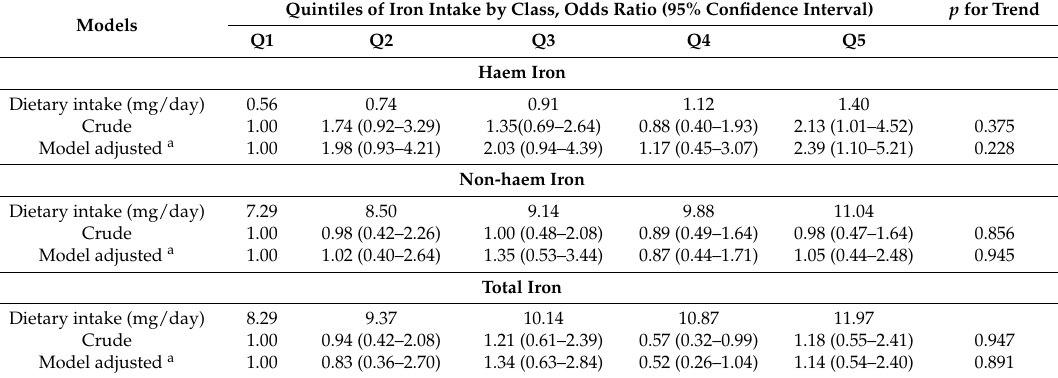
Table 1. Association between quintiles of iron intake (haem, non-haem and total) and metabolic syndrome in ISA-Capital. S ã o Paulo, Brazil, 2008.